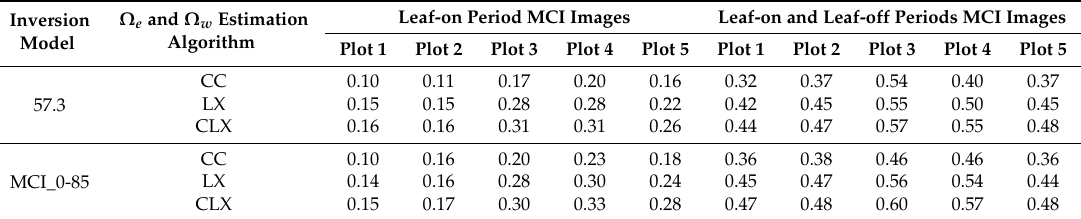
Table 8. α estimates obtained with consideration of Ω e and Ω w by using the leaf-on period MCI images in the five